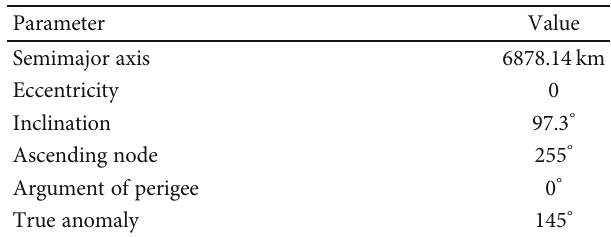
Table 5: Orbit parameters.